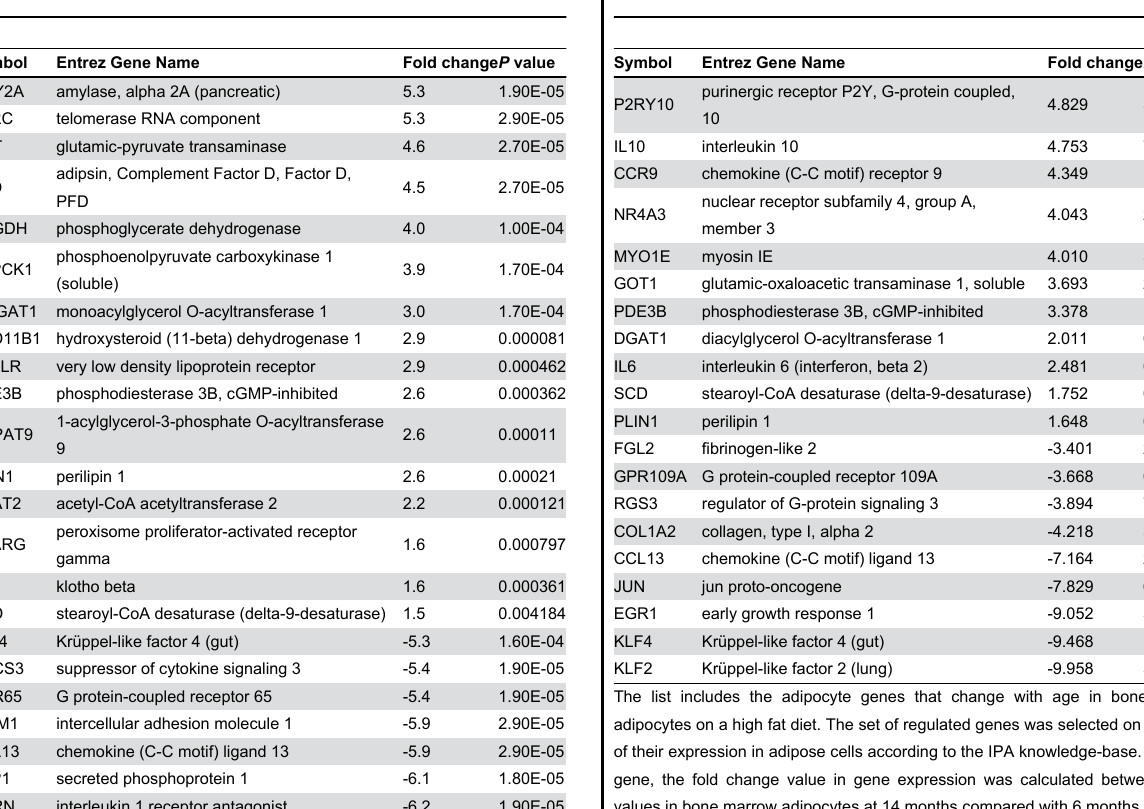
Table 9. Epididymal adipocyte genes most highly up- and down-regulated with age during a high fat diet.